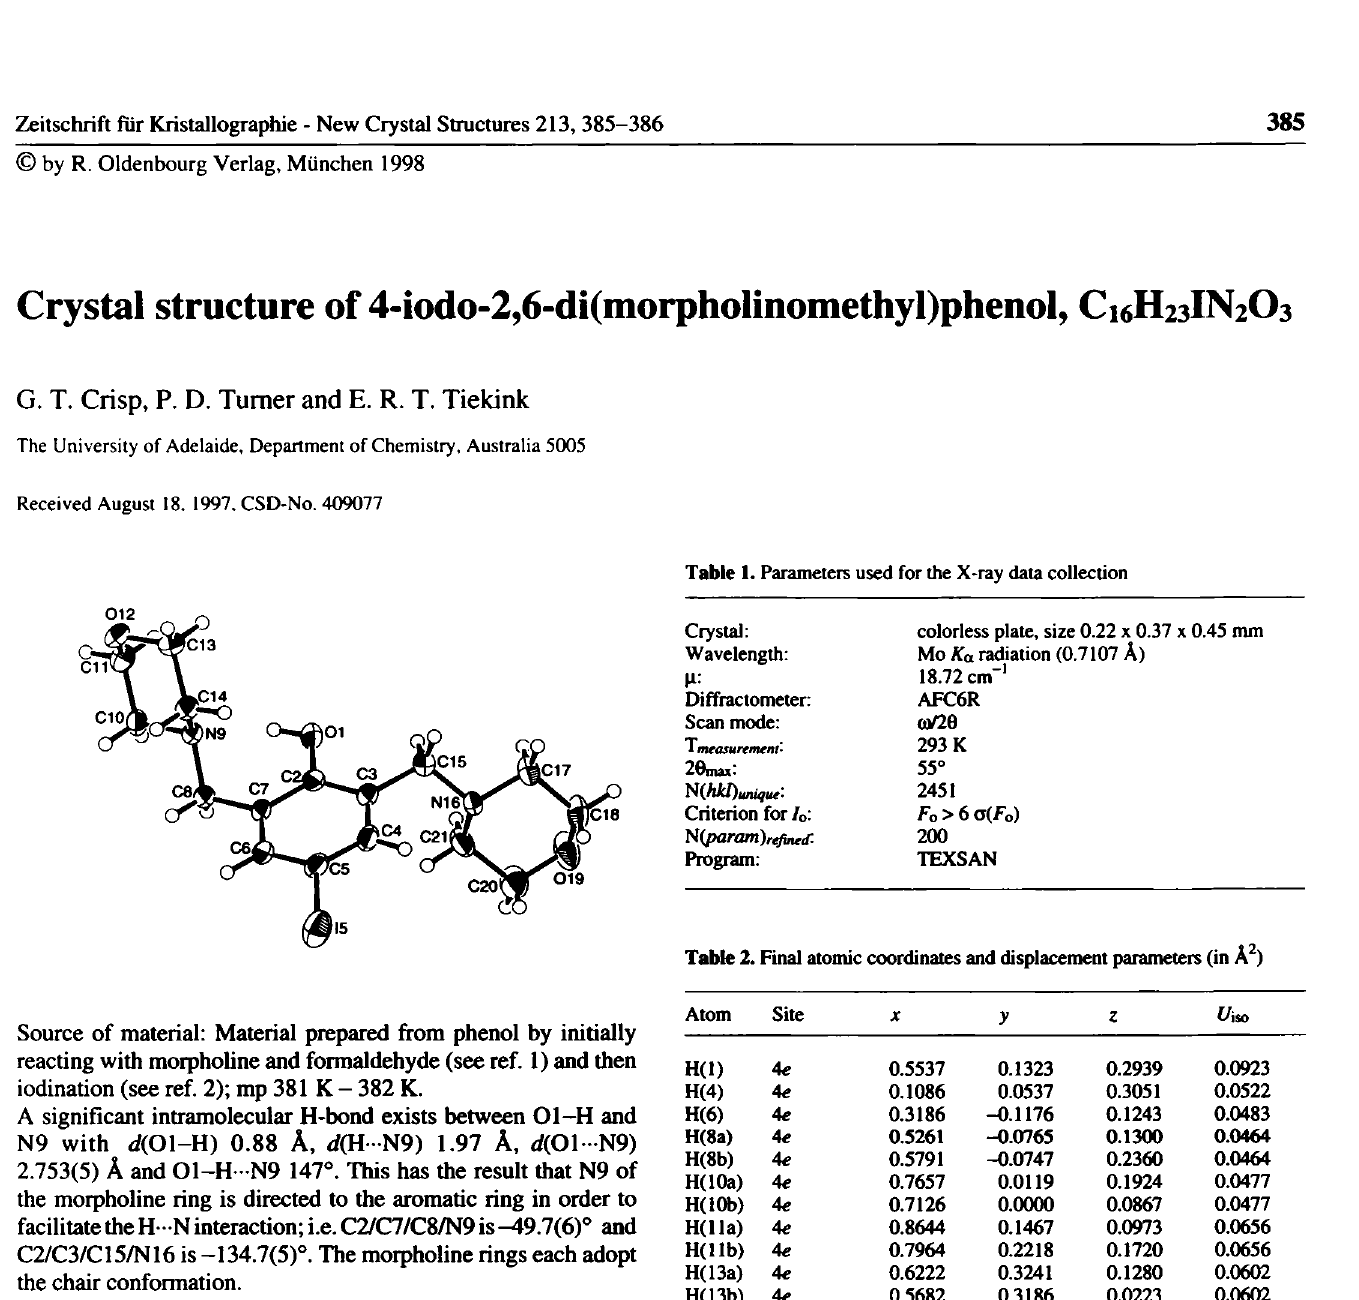
Table 3. Final atomic coordinates and displacement parameters (in